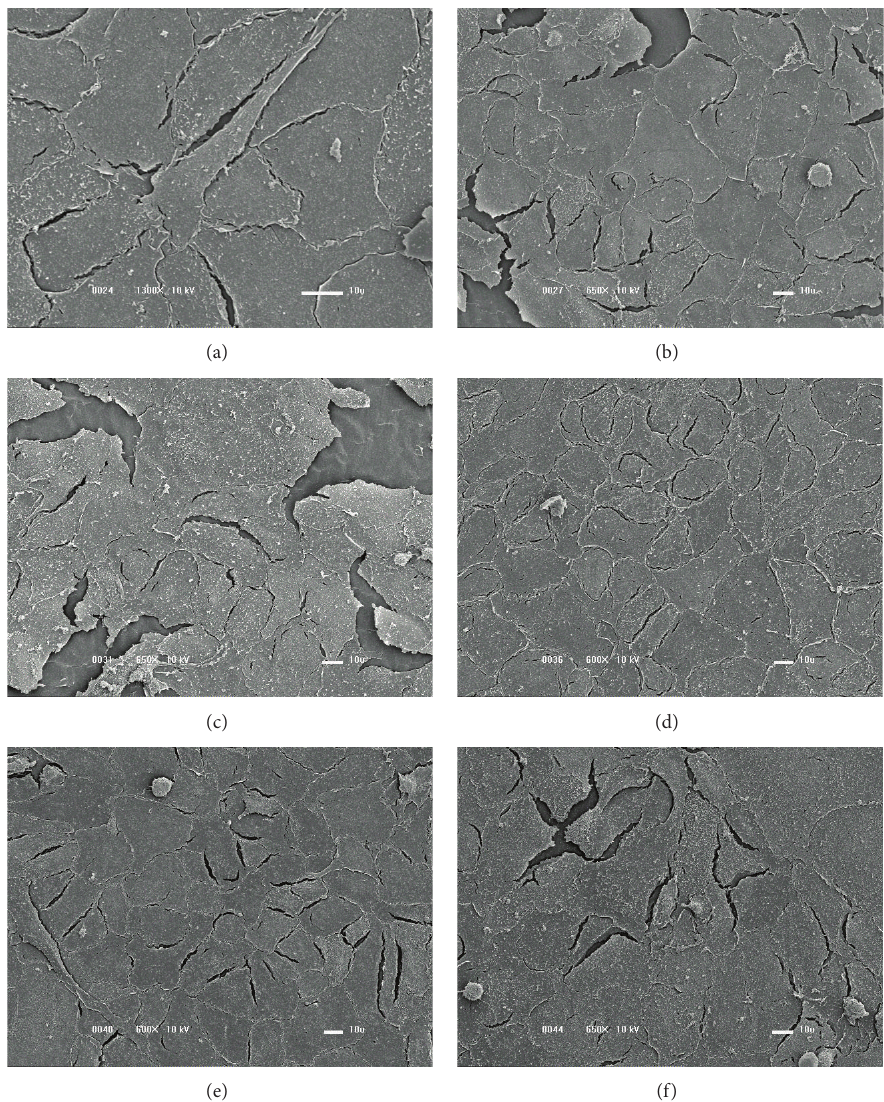
Figure 8: SEM surface images of the PVC samples after 24 hours of cellular cultivation. (a) Nontreated PVC plate. Sample covered with films = 5.3 %, (c) P = 28.9 %, (d) P = 44.7 %, (e) P = 55.3 %, and (f) P = 65.8 prepared with (b) P Ar Ar Ar Ar Ar